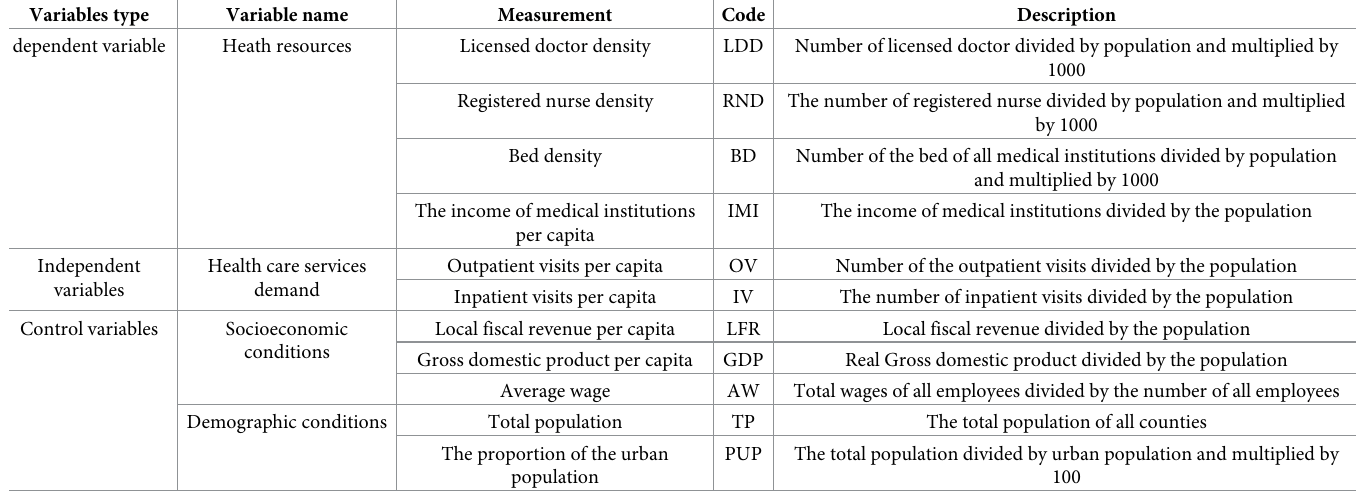
Table 2. Variables and data